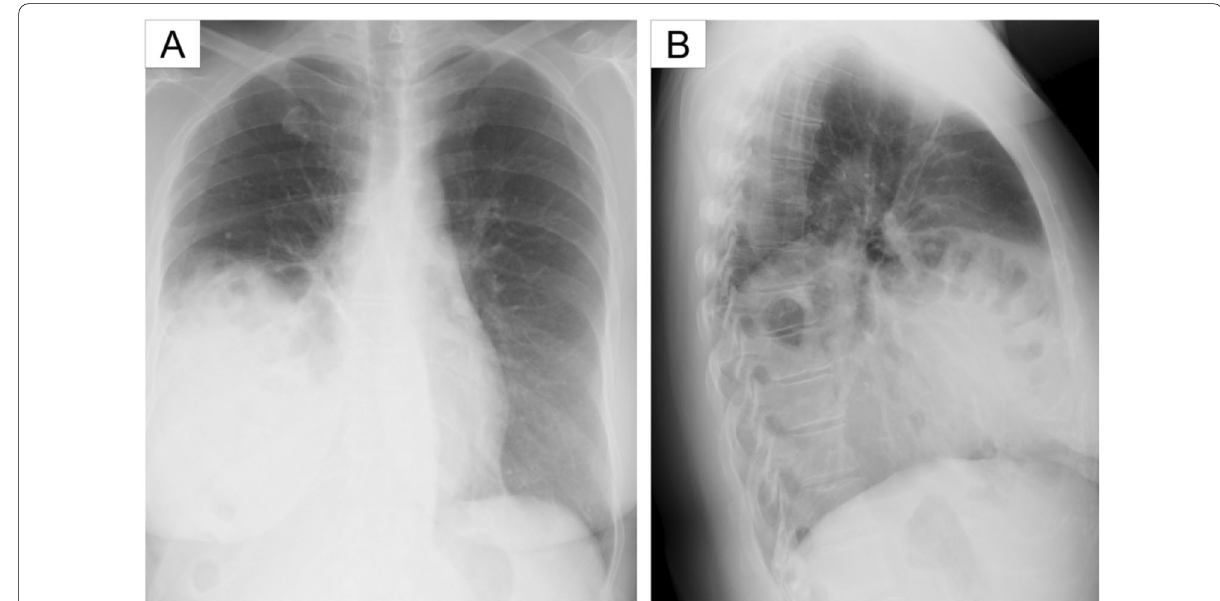
Fig. 1 Preoperative chest radiography. a Frontal chest radiography showed a massive area of opacity in the right lung field. b Lateral chest radiography showed intestinal gas in opacity in the lung